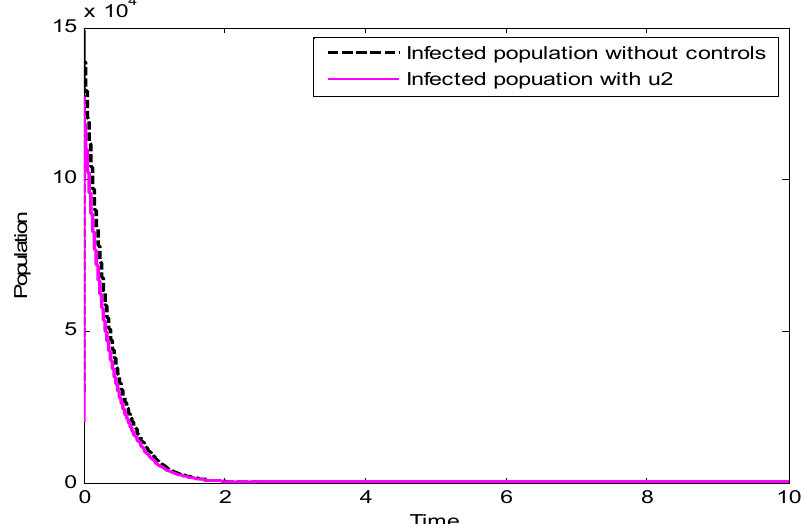
Figure 3. Comparing the dynamics of the infected population without control and with control u 1 .